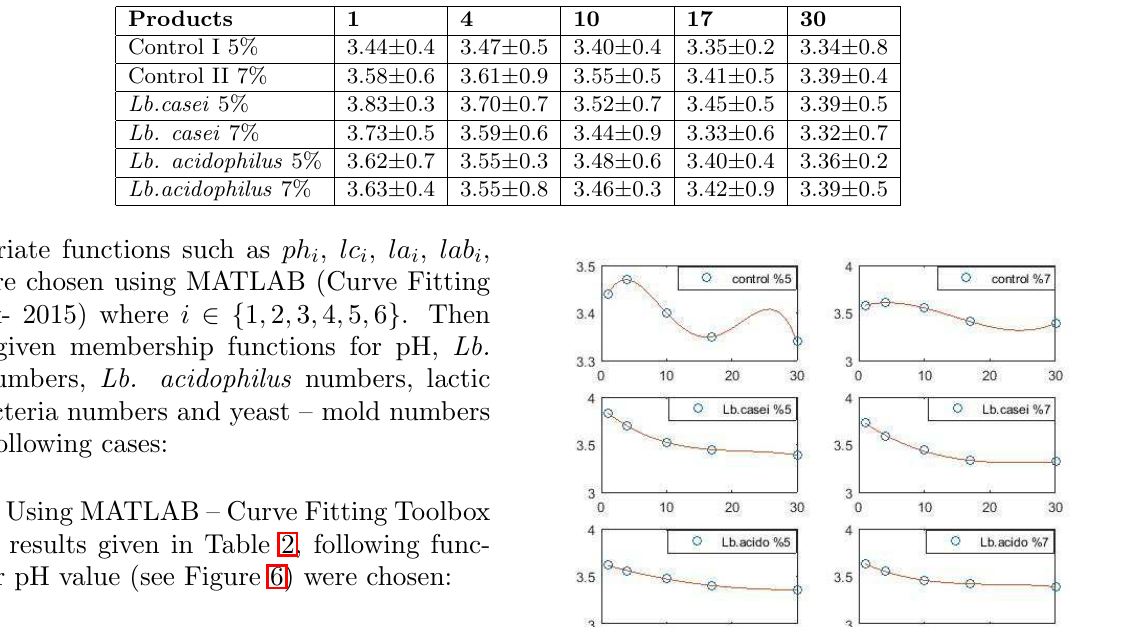
Table 2. pH ± standard deviations (S.D.) of pickles during the storage at (1., 4., 7., 10., 17. and 30. days) +4 ◦ C.